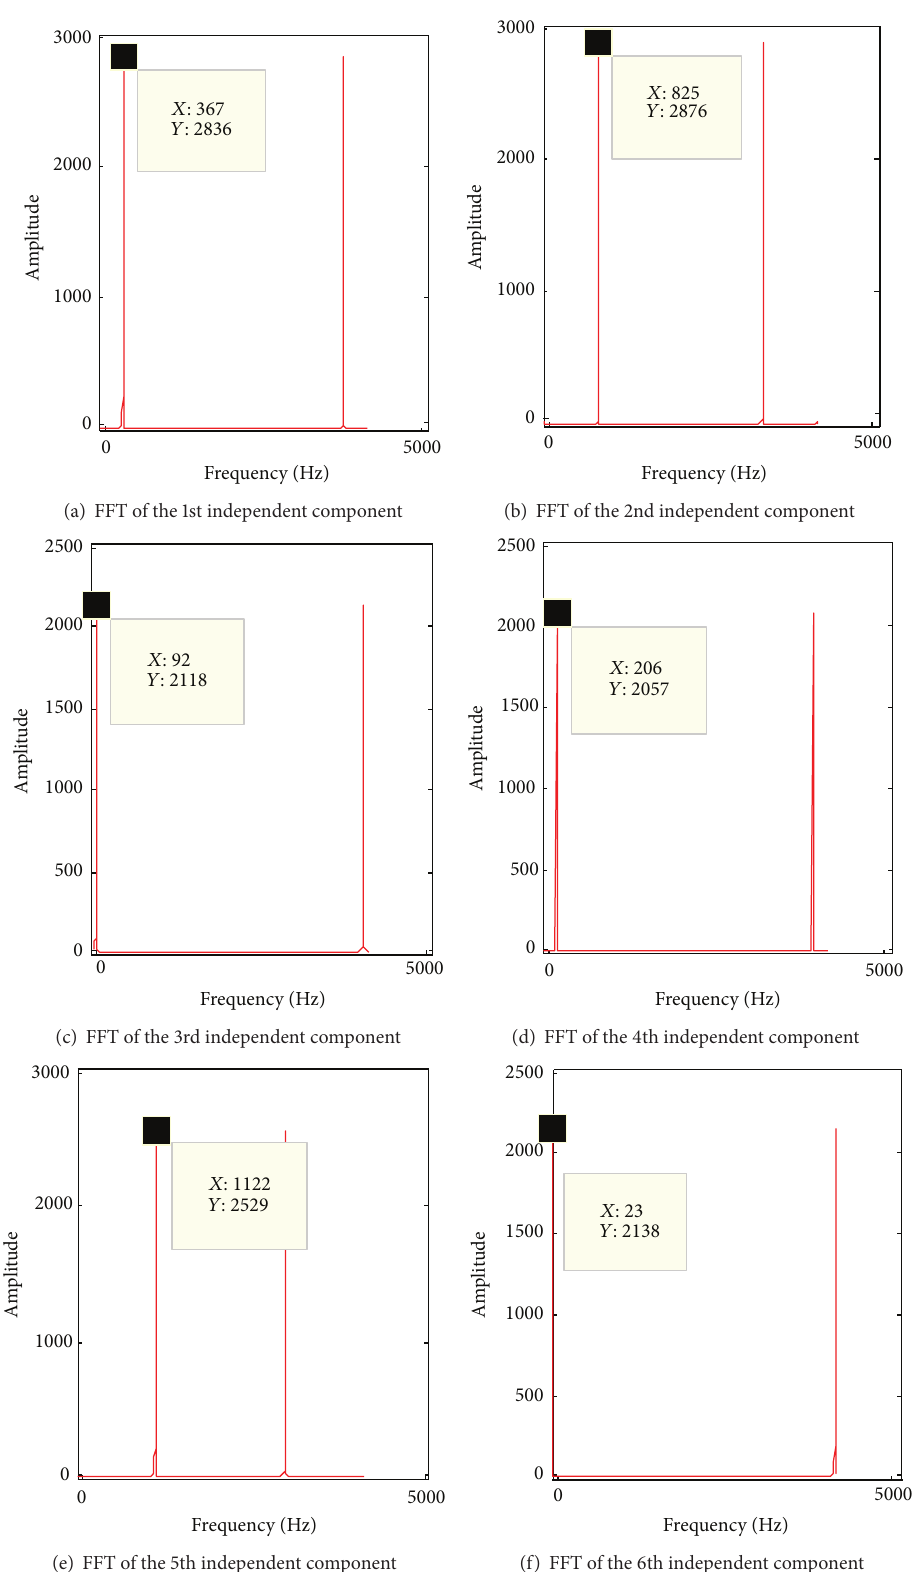
Figure 5: FFT of each independent component identified by maximization negentropy with quasi-Newton